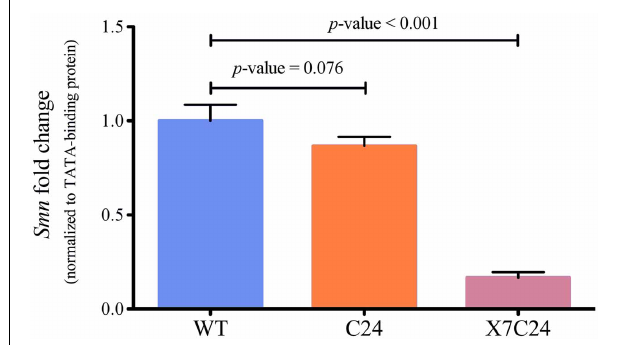
FIGURE 5 | RT-qPCR quantification of Smn expression levels in CNS samples from WT, C24, and X7/C24 fly strains. Average fold change and standard deviation ( N = 3). Relative expression levels determined with the 2 ∧ ddCt method using the TATA-Binding protein as reference gene. Smn is only significantly down regulated in Smn X7 /elavGAL4-C24 (X7/C24) flies ( t -test p -value <